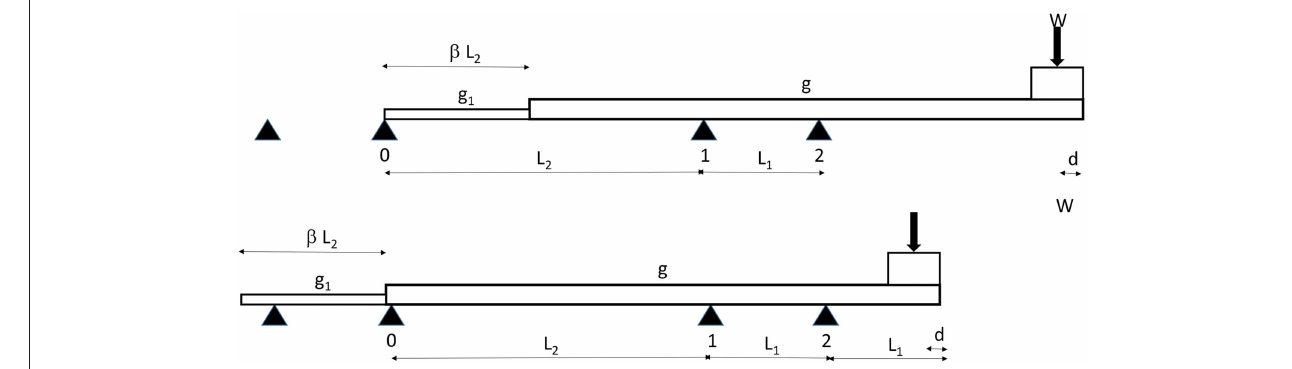
FIGURE 10 | Launching schemes.